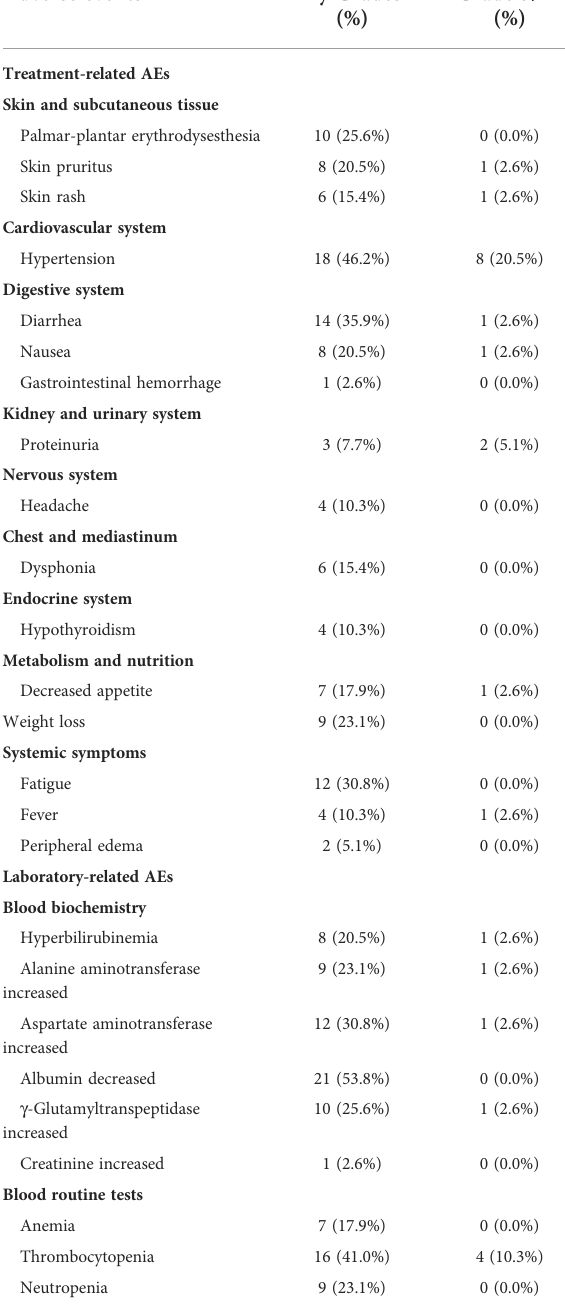
TABLE 8 Summary of adverse events. Adverse